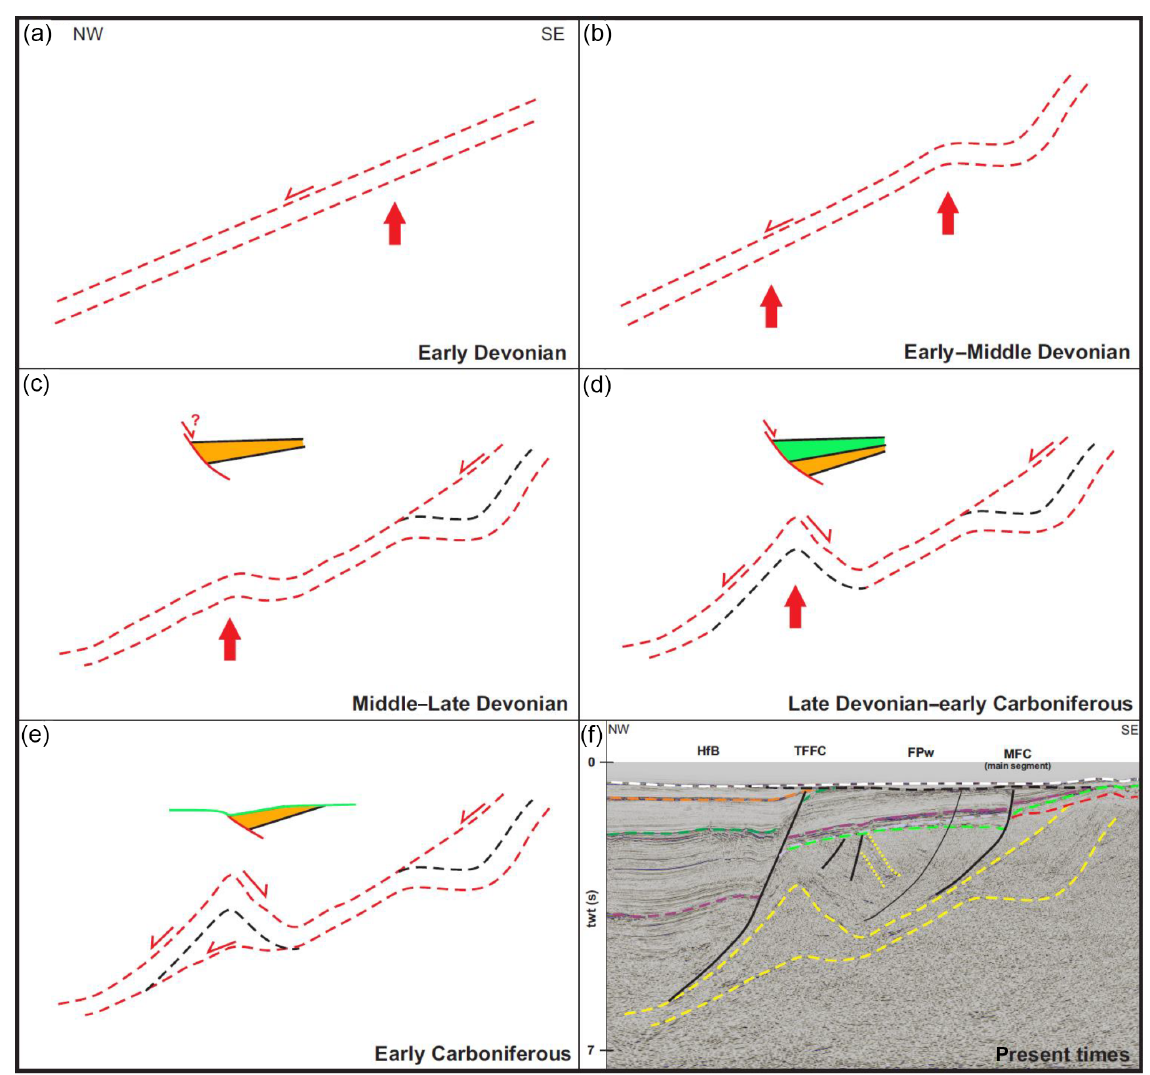
Figure 10. Evolutionary model explaining thickness variations along the SISZ. Note that the timing of (a) to (e) is tentative. Dashed red lines in panels (a) to (e) correspond to tectonically active portions of the SISZ whereas dashed black lines show inactive portions. Red lines in panels (c) , (d) , and (e) show presumed normal faults. Thick vertical red arrows indicate exhumation of basement rocks along the SISZ. The model is adapted to the geometry of the SISZ observed below the western Finnmark Platform (see panel f ); (a) extensional reactivation (thin red arrow) of the SISZ in Early Devonian times. Rapid crustal thinning and possible erosion along the upper part of the SISZ triggers exhumation of basement rocks near the coast of NW Finnmark (thick red arrow); (b) in the Early–Middle Devonian, continued extension and erosion further thin the crust and exhume basement rocks in the footwall of the SISZ, leading the upper part of the SISZ to bow. Incremental crustal thinning due to continued extensional reactivation of the SISZ and continental erosion triggers exhumation of basement rocks along lower portions of the SISZ (left-hand side, thick red arrow); (c) in Middle to Late Devonian times, bowed portions of the SISZ become inactive and excisement (i.e., upwards splaying; see Lister and Davis, 1989) of the SISZ into its hanging wall leads to thickening of the upper portion of the SISZ. Continued extension and erosion (i.e., crustal thinning) trigger bending of the lower part of the SISZ (thick red arrow) above which brittle normal faults may have formed and localized the deposition of Devonian sedimentary deposits (orange); (d) further exhumation of basement rocks along lower portions of the SISZ in the Late Devonian–early Carboniferous leads to extreme bending of the SISZ, to antithetic top–SE extensional faulting, and to early Carboniferous syn-tectonic sedimentation (green); (e) towards the end of the early Carboniferous, the lower portion of the SISZ is thickened due to incisement (i.e., downward splaying; see Lister and Davis, 1989) of the SISZ into bow-shaped portions in its footwall. Core complex exhumation ceased in the Serpukhovian and a major sea-level fall exposed the Finnmark Platform to continental erosion (green line representing the mid-Carboniferous reflection); (f) present seismic expression of thickness variations along the SISZ (dashed yellow) on the western Finnmark Platform. See Fig. 5 for seismic reflections color schemes.